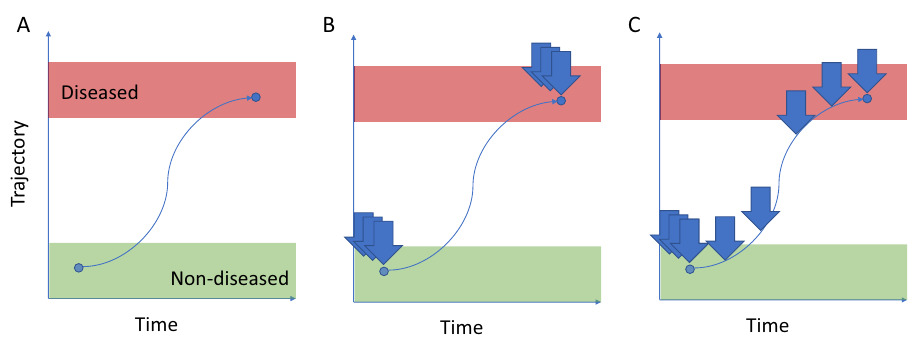
Fig. 1 Prospective risk can be represented as a trajectory. Red and green zones represent positions on the trajectory corresponding to outward de fi nitions of diseased and non-diseased status. Vertical arrows represent sampling of population at a particular point of a trajectory. A The (single-class) case-control paradigm often imposes a dichotomous (binary) framework onto a continuous trajectory. B Experiments utilizing observations of cases that are concentrated at the time when the case event occurs cannot capture any information regarding the transition trajectory, resulting in temporal bias. C In order to predict a patient ’ s position along the trajectory, experiments capturing the entire transition from non-diseased to diseased